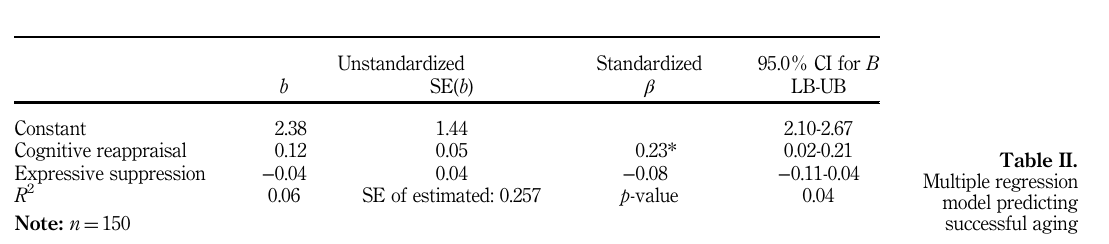
model predicting successful